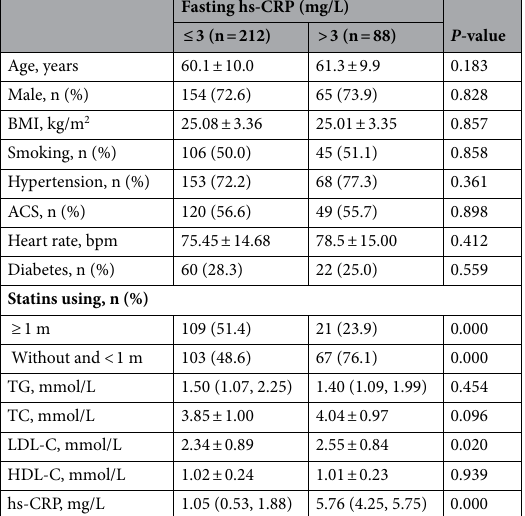
Table 1. Comparisons of baseline characteristics between two groups. The levels of blood lipids and hs-CRP were measured in the fasting state. Age, body mass index (BMI), heart rate, TC, LDL-C, HDL-C were expressed as mean ± standard deviation (M ± SD). TG and hs-CRP were expressed as median with 25th and 75th percentiles. Others were expressed as numbers and